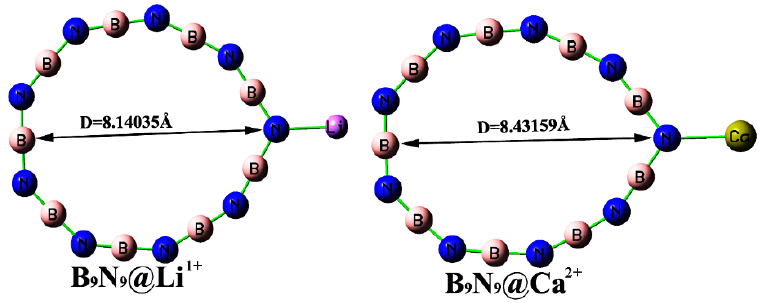
Figure 11. Structure of the two complexes. Table 4 . Geometric structure and charge variation in different ionic complexes of B 9 N 9 .